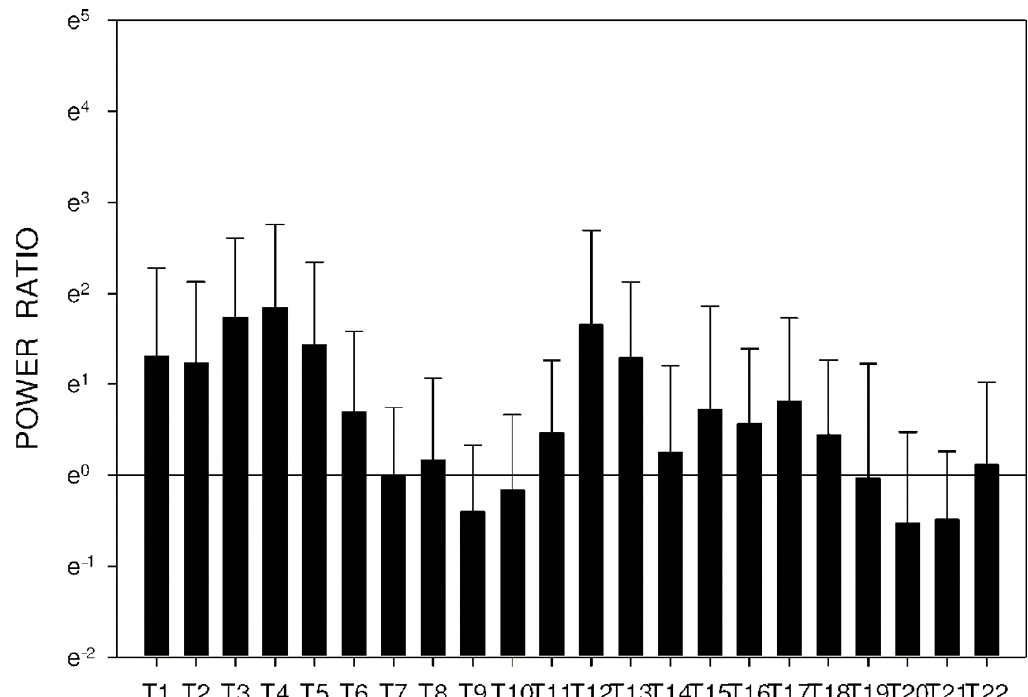
Figure 16. Electrogastrography power ratio after an intragastric administration of 10 mg donepezil (on day 8; group C) with preceding 7-day administration of donepezil (5 mg per day) and dextran sodium sulfate (10 g per day). Outliers omitted. Y axis: natural log scale.